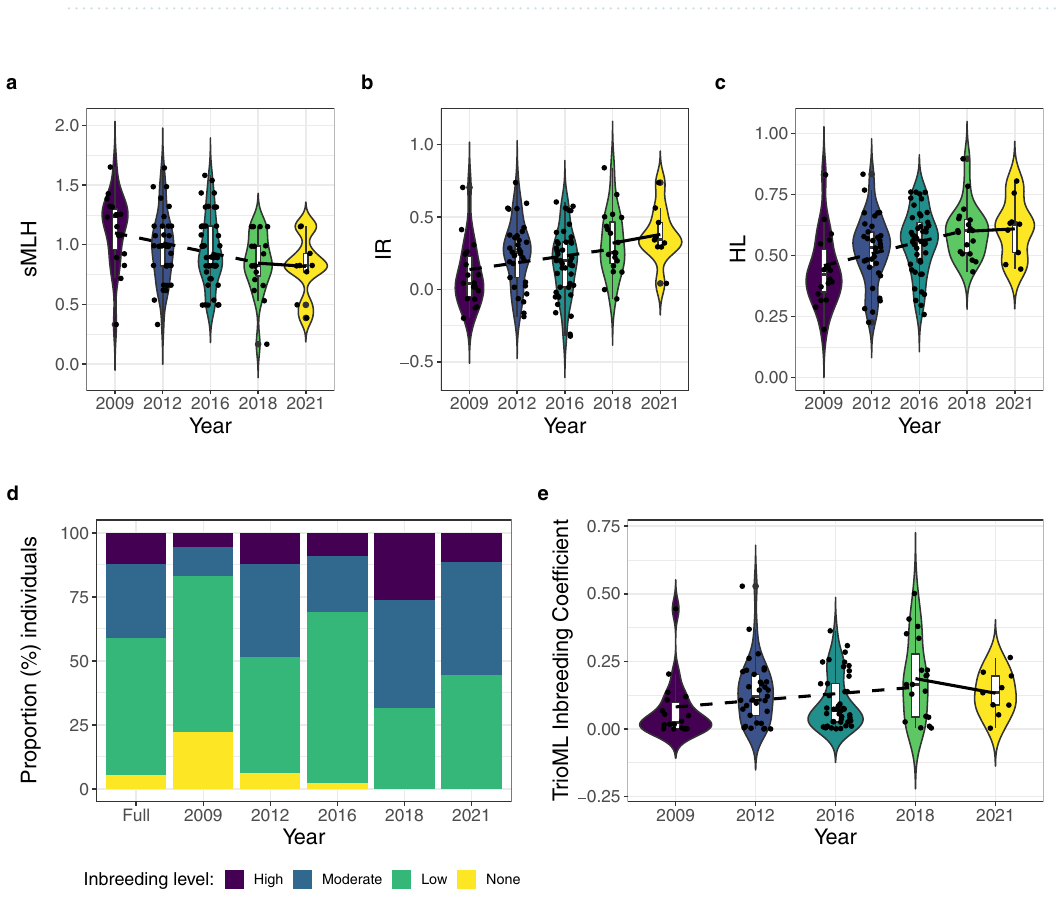
Figure 1. Violin plots showing temporal changes in heterozygosity and inbreeding in the captive peninsular pronghorn. Panels ( a – c ) show changes in three frequency-weighted measures of individual heterozygosity: standardized multilocus heterozygosity (sMLH), internal relatedness (IR) and homozygosity weighted by locus (HL) respectively. Panel ( d ) shows bar charts depicting the proportion (%) of individuals falling within different inbreeding classes, from none ( f = 0), through low ( f = < 0.125) and moderate (0.125 < f < 0.25) to high ( f > 0.25), as estimated using TrioML. Panel ( e ) shows violin plots of changes in the inbreeding coefficient, estimated using TrioML. In panels ( a – c ) and ( e ), the boxplots span the first to third quartiles, with horizontal lines inside the boxes representing the medians. The raw data are plotted as black points and the lines connecting the boxplots correspond to regression lines smoothed and fitted with the “glm” function separately for the years 2009–2018 (dashed lines) and 2018–2021 (solid